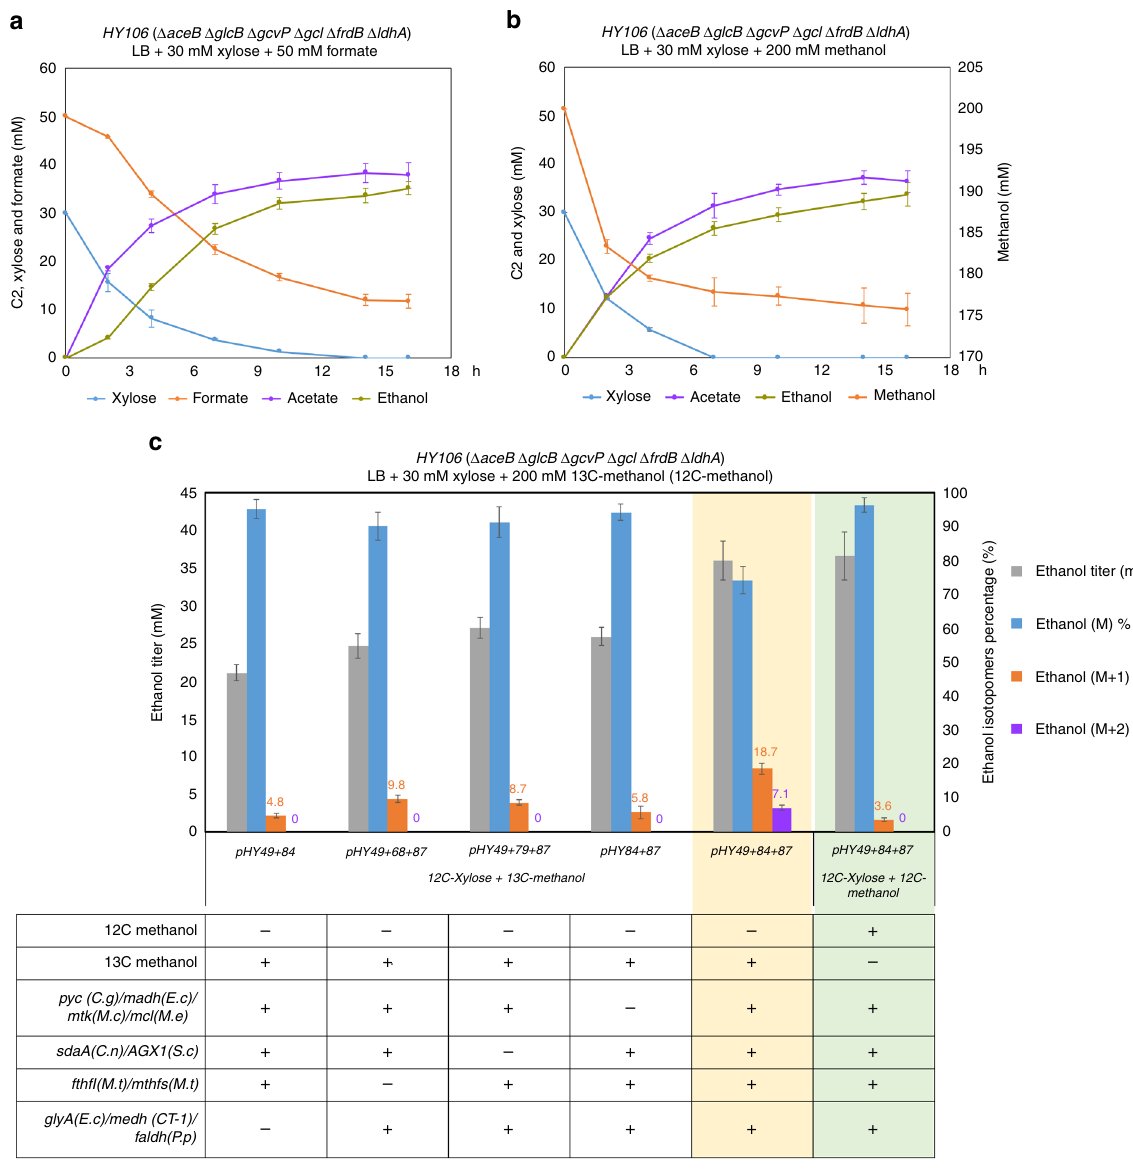
Fig. 5 Expression of the modi fi ed serine cycle improved the production of C2 compounds and condensed methanol to ethanol in E. coli . a Time course of the C2 production and carbon consumption during co-assimilation of formate with xylose. The formate assimilation rate was calculated between the second to fourth hour. b Time course of the C2 production and carbon consumption during co-assimilation of methanol with xylose. The methanol assimilation rate was calculated between the time zero to second hour. c Demonstration of condensing methanol into ethanol in the E. coli strain HY106 with expressing the modi fi ed serine cycle genes. The strains were incubated in LB medium with supplements of 30 mM xylose and 200 mM 13C-methnaol (or 200 mM 12C- methnaol) for 20 h. Error bars are s.d., n =